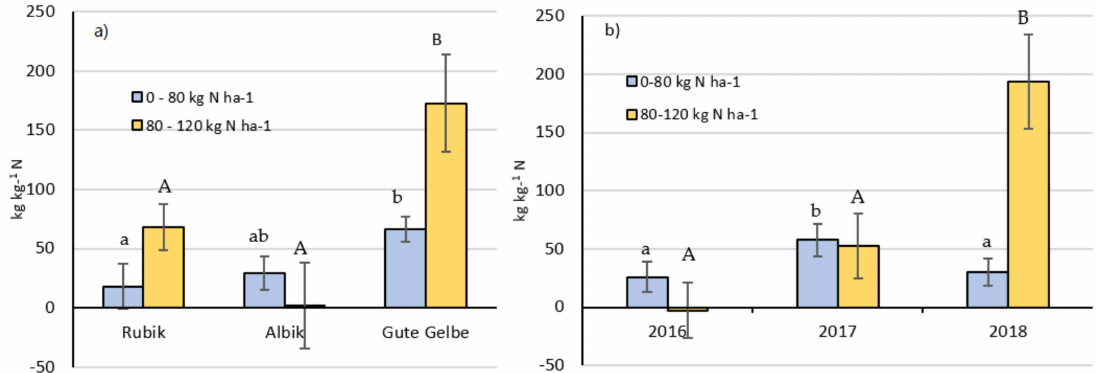
Figure 4. Marginal N-use efficiency (ME) for cultivars ( a ) and years of the study ( b )–(average ± SE, lower case letters for rate 0–80 kg N ha − 1 ; upper case letters for rate 80–120 kg N ha − 1 ; bars followed by the same letters do not differ significantly at p <